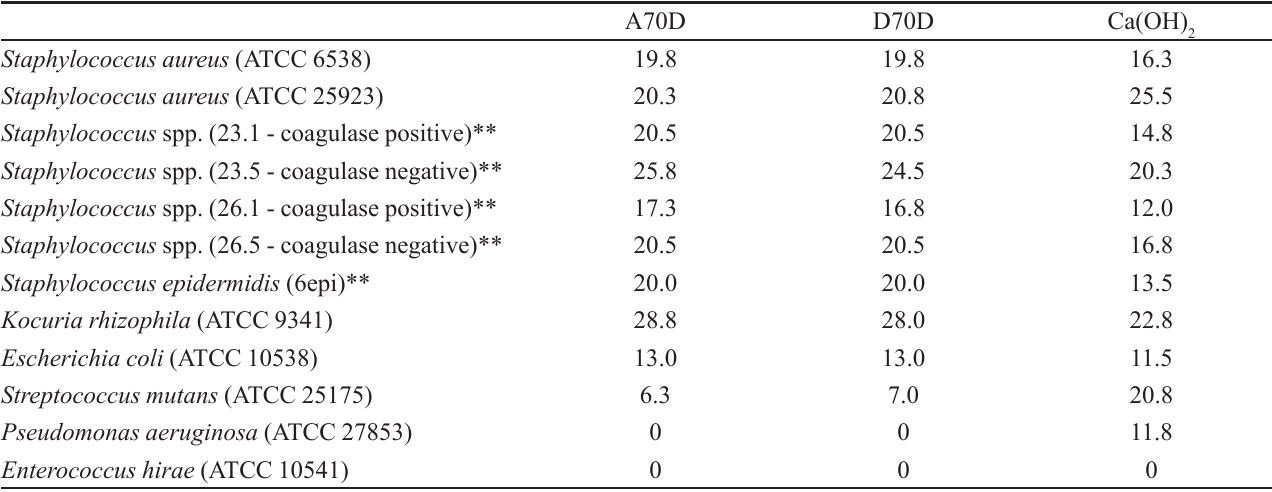
TABLE I - Susceptibility test of pathogenic microorganisms to propolis-based toothpastes for use in endodontics. Mean inhibition zone (mm)*